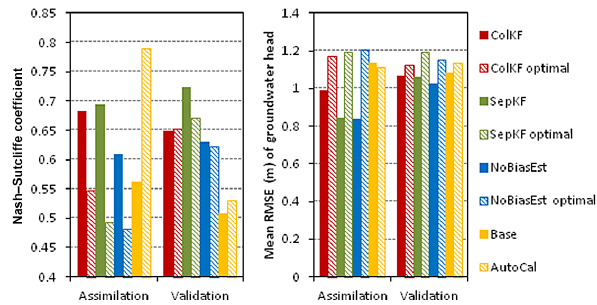
Figure 9. Groundwater head as a function of time in head observa- tion location well 64 (real